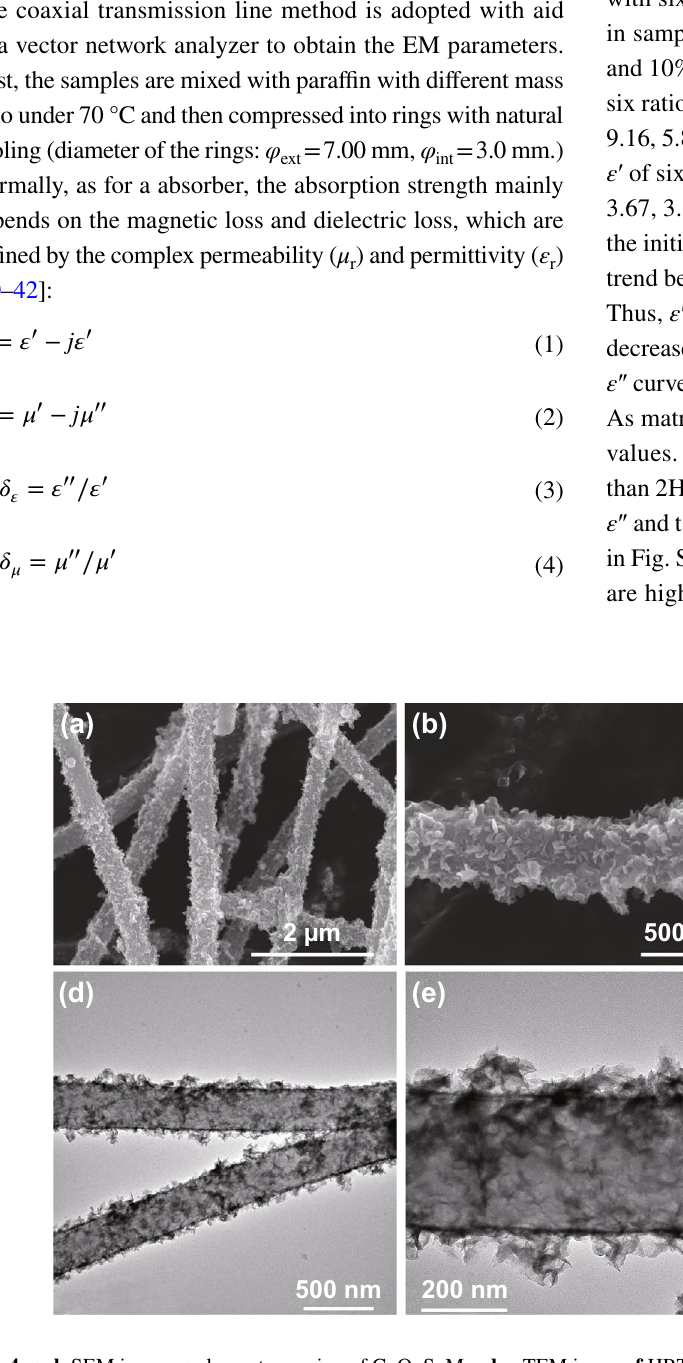
Fig. 4 a , b SEM image, c element mapping of C, O, S, Mo, d , e TEM image, f HRTEM images of CF@1T/2H MoS